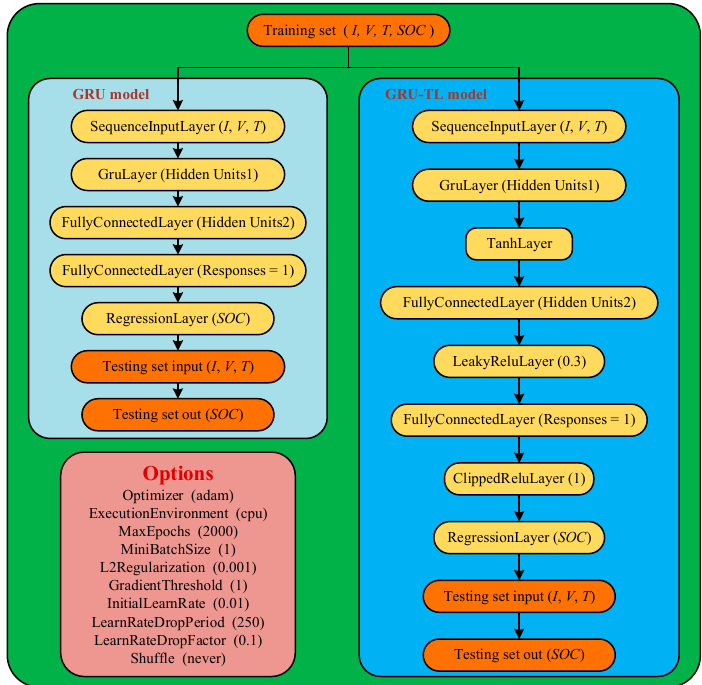
Figure 2. Schematic diagram of a GRU-RNN network model with an activation function layer (GRU-ATL) network structure.